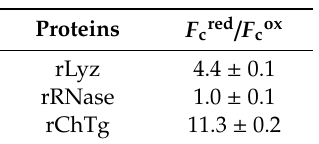
Table 3. ANS fluorescence a